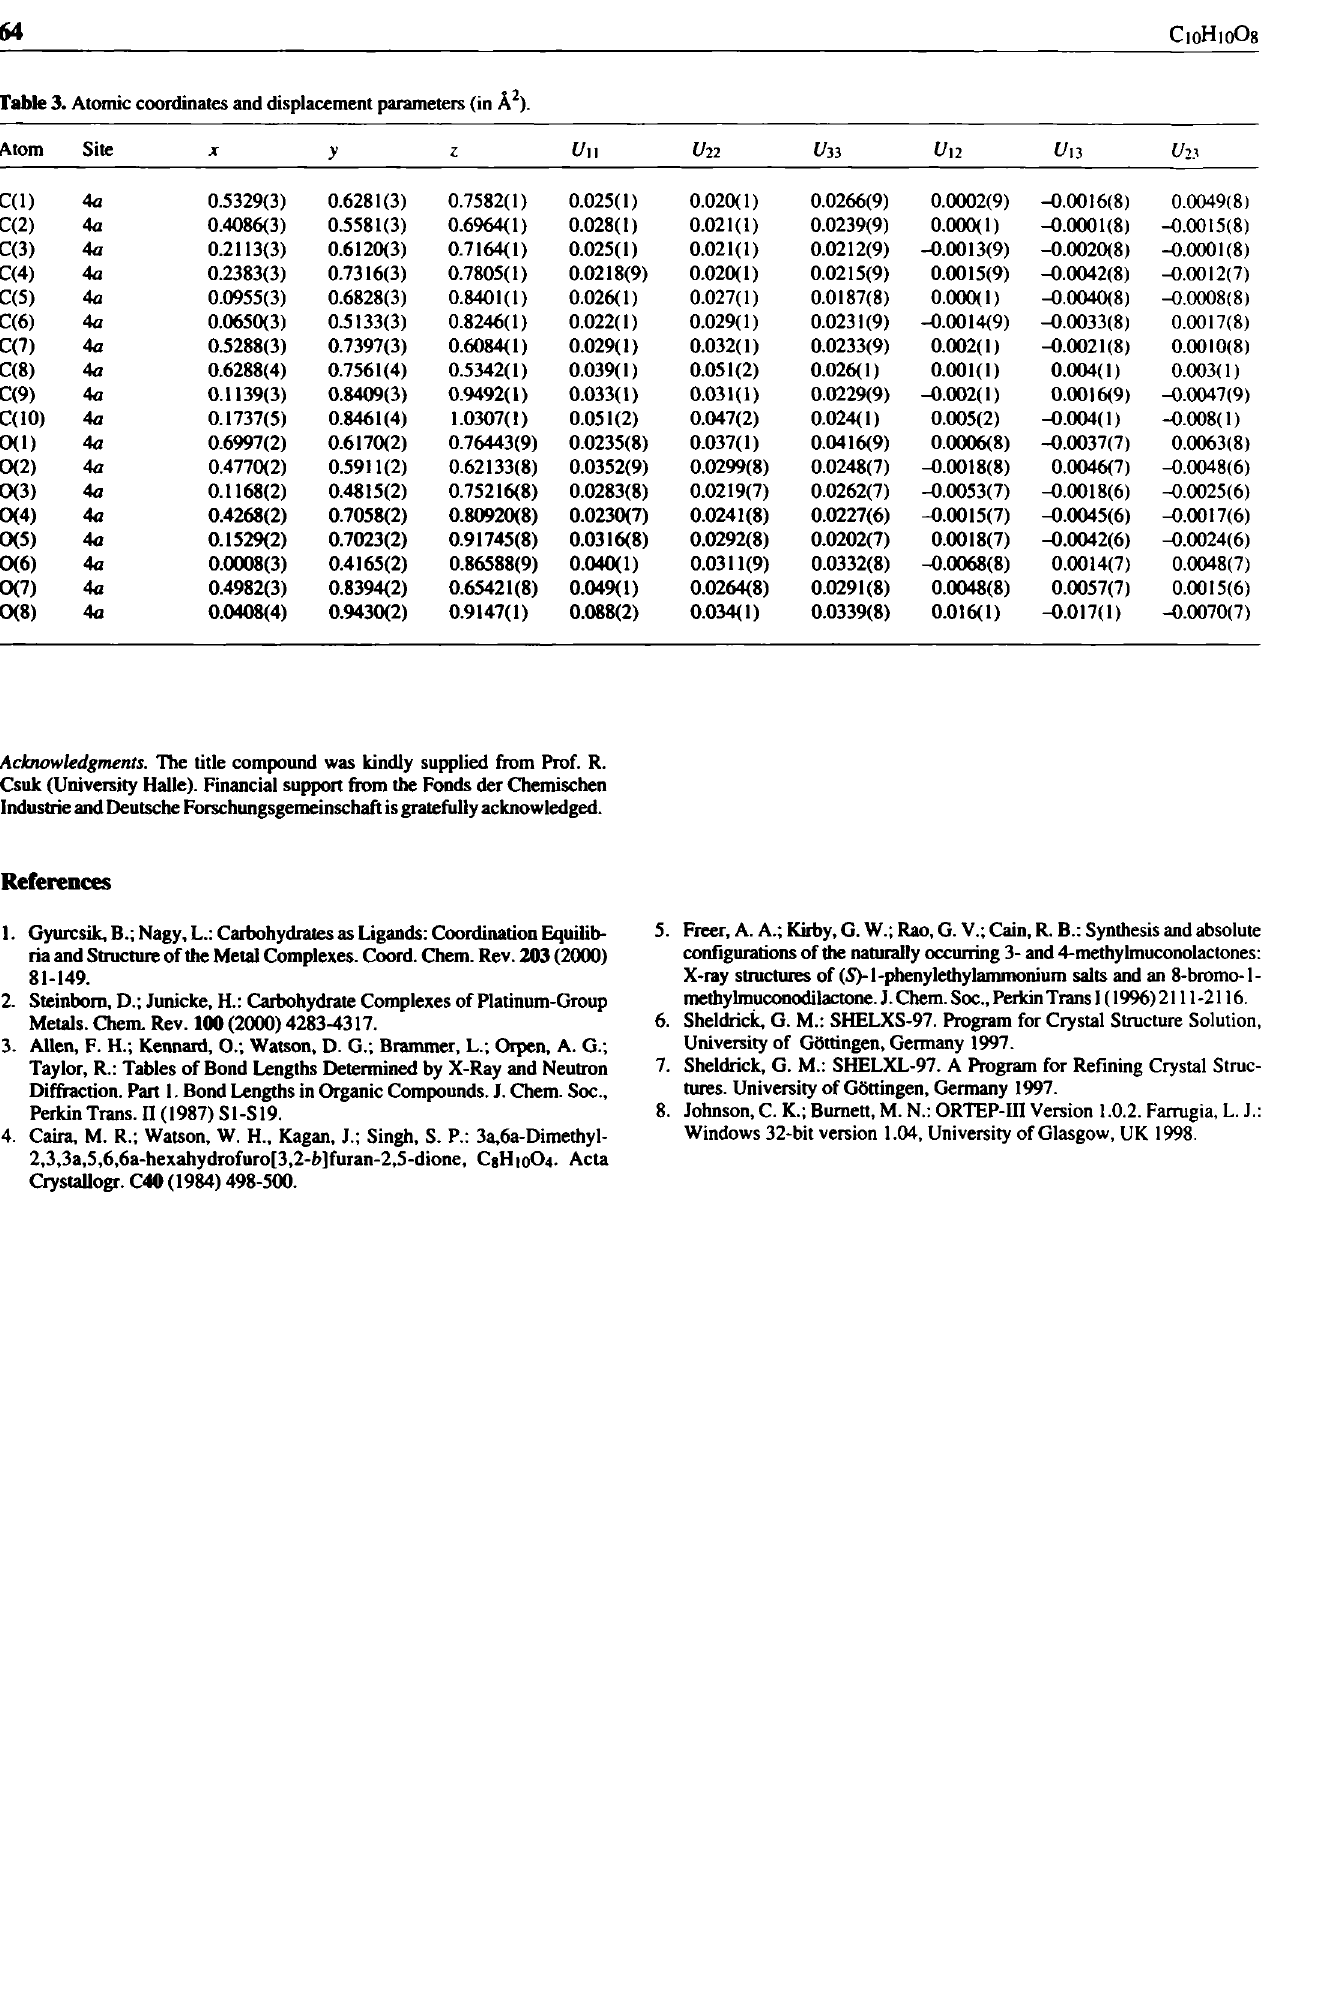
Table 3. Atomic coordinates and displacement parameters (in Â 2